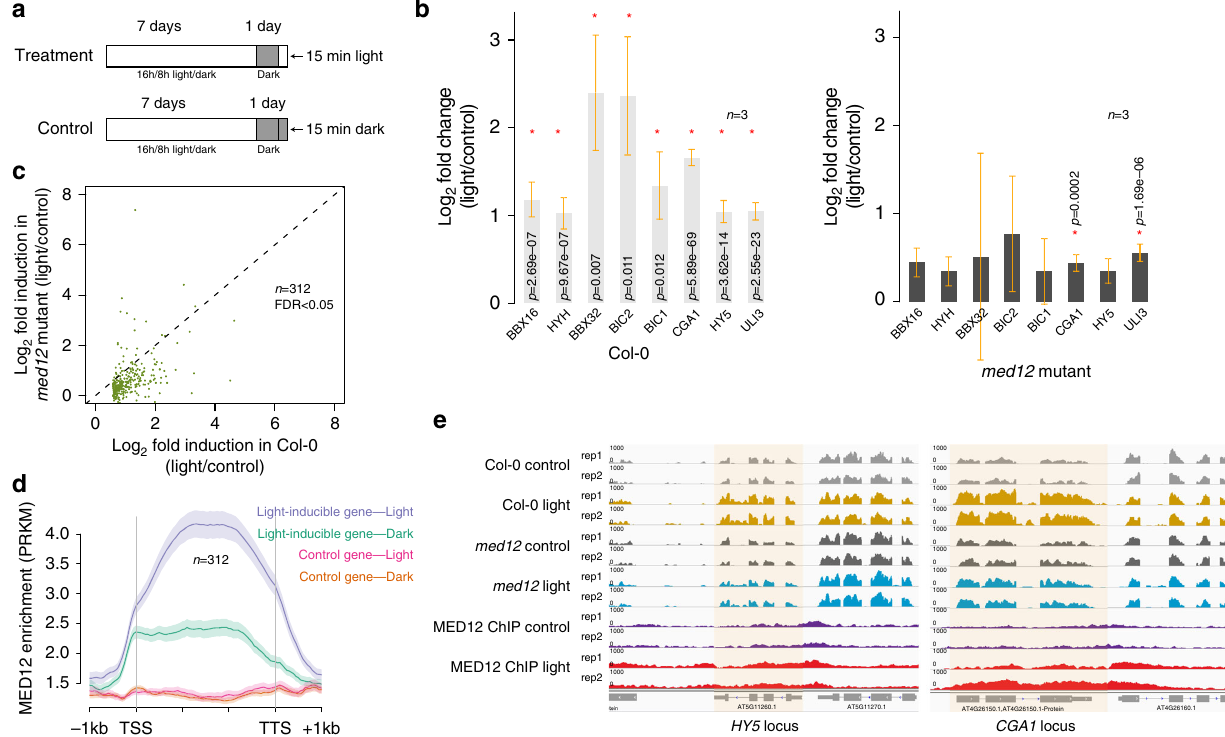
Fig. 7 Role of MED12 in mediating light-induced transient gene expression. a Schematic illustration of the light and control treatments. b Bar plot of light- responsive gene fold induction under light treatments. Left, wild-type plants (Col-0); Right, med12 mutant plants. Asterisks indicate statistical signi fi cance in gene expressional changes (Benjamini – Hochberg adjusted p value, two sided). Data are presented as mean values + / − SE. n = 3 biologically independent samples. c Scatter plot showing the fold induction of light-inducible genes in Col-0 and med12 mutant plants upon light treatments. Each dot represents one light-inducible gene with its x -axis position showing fold induction in Col-0 and y -axis position showing fold induction in med12 mutant. The dotted line represents the 45° reference line. d The average distribution of MED12 over light-inducible genes and control genes in the light-treated (purple and red) and non-treated (green and orange) plants. Shaded area represents the standard error (SEM) centered on mean value (dark solid lines). n = 3 biologically independent samples. e Screen shots showing gene expression and MED12 enrichments at HY5 (left) and CGA1 (right) locus under the light- treated and non-treated conditions. Top four tracks, gene expression in Col-0; middle four tracks, gene expression in med 12 mutants; bottom four tracks, MED12 enrichments in MED12 complementing plants. Source data underlying b , c are provided as a Source data fi